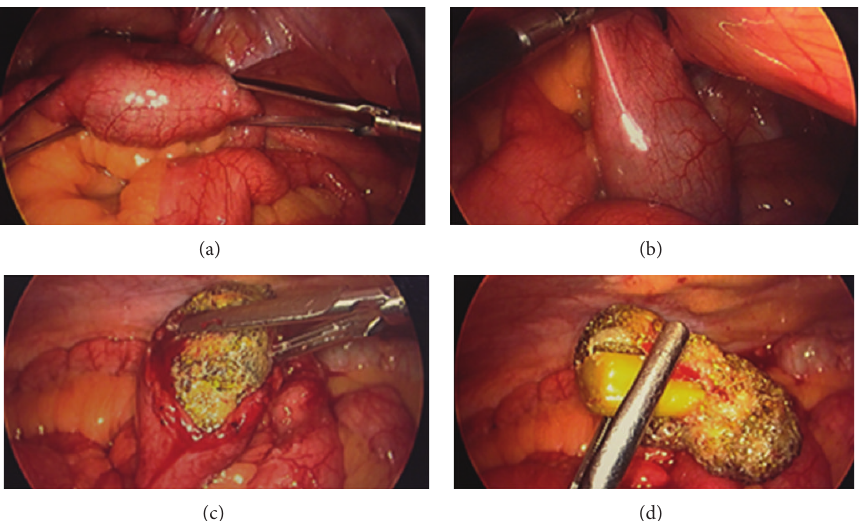
Figure 4: (a) Intraluminal mass distal small bowel, (b) intraluminal mass distal small bowel, (c) extraction of broccoli from small bowel, and (d) undigested/unchewed piece of broccoli.